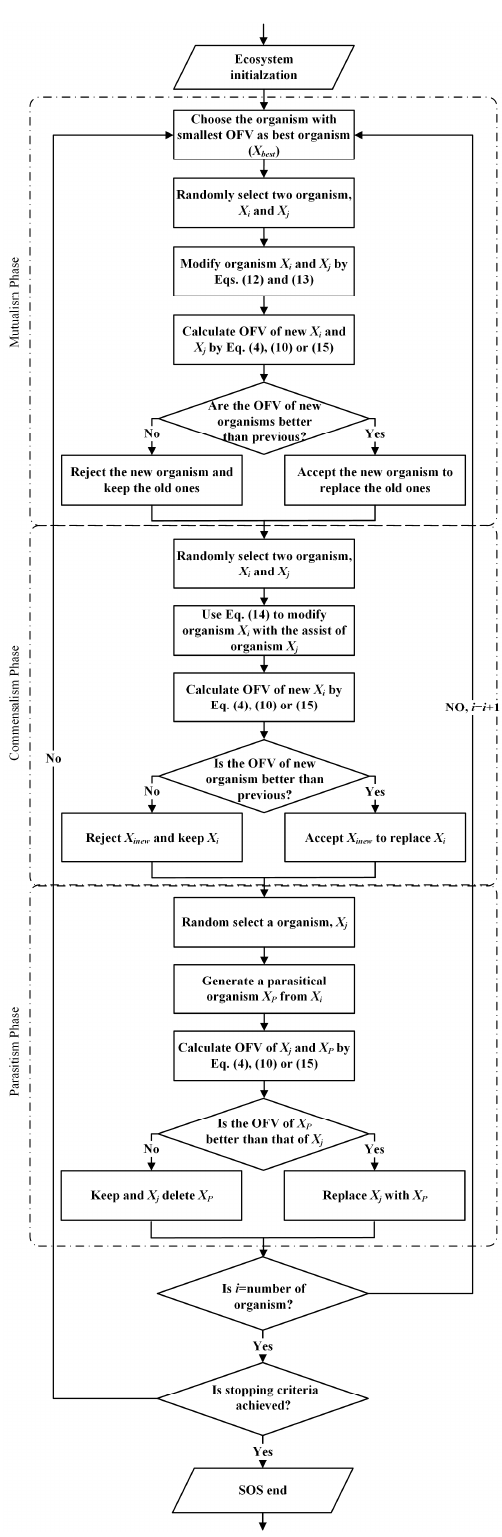
Figure 3. Flowchart of symbiotic organism search (SOS).